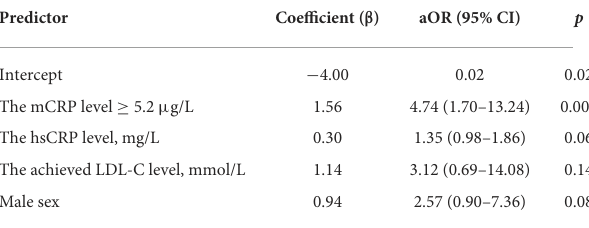
TABLE 5 The results of the logistic regression model predicting the formation of new atherosclerotic